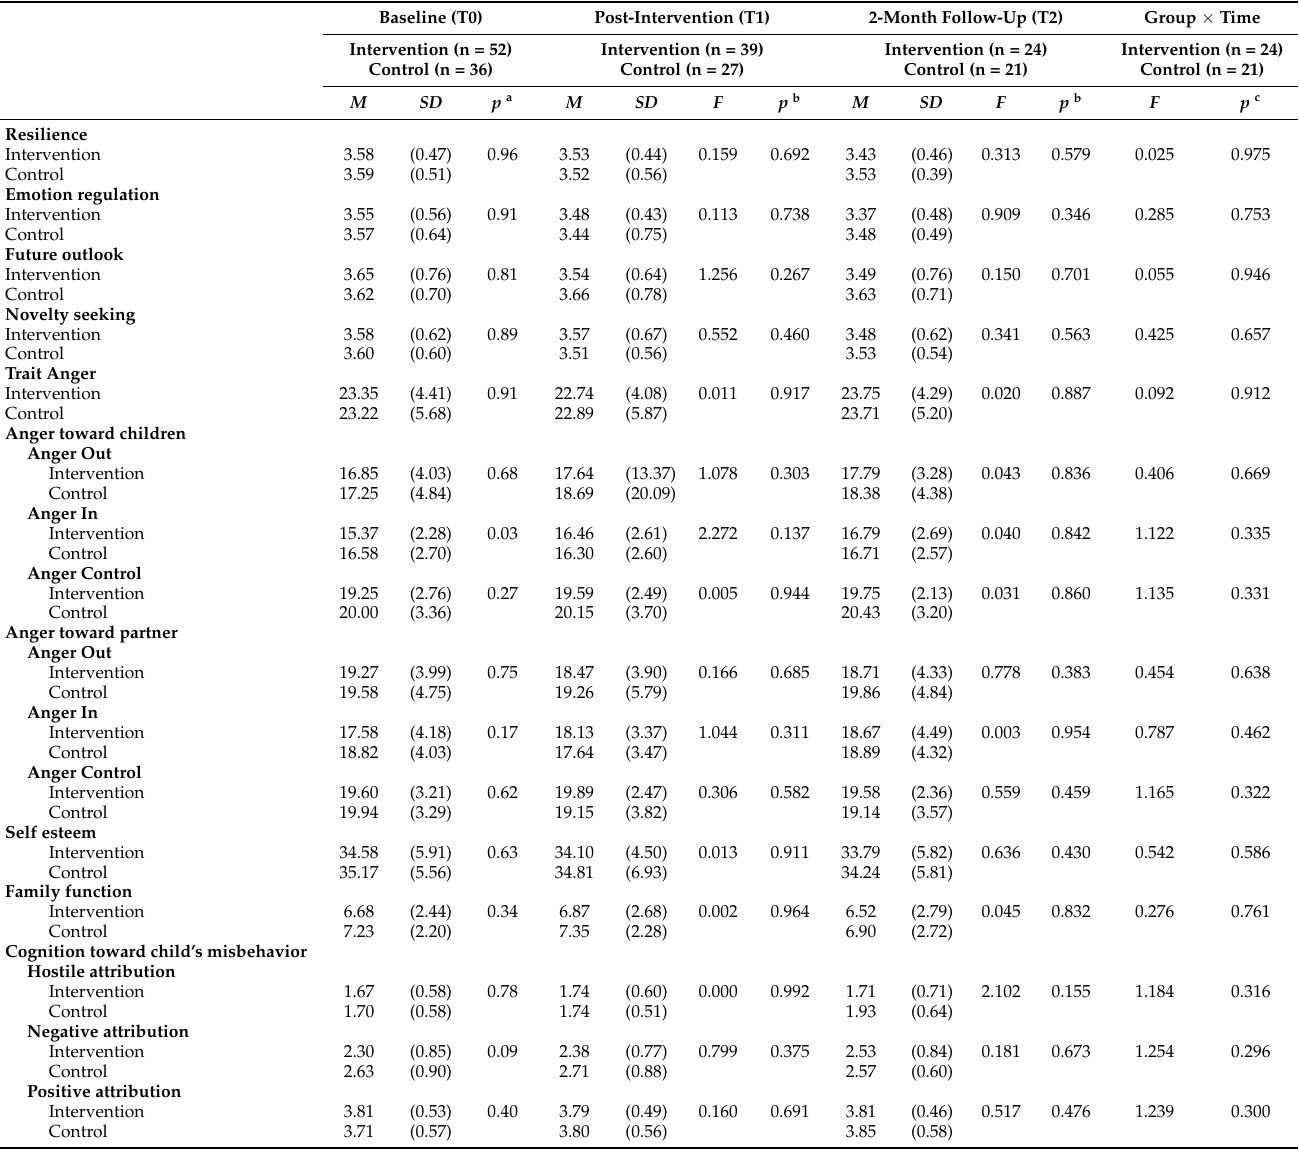
Table 4. Comparison between groups